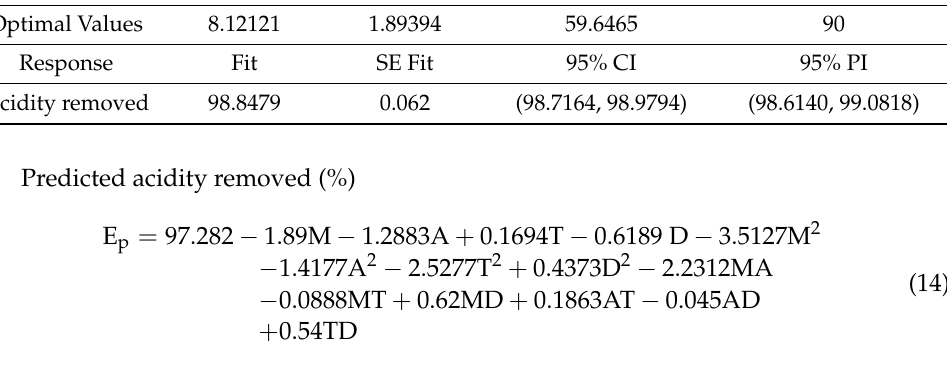
Figure 24. Acidity removed (experimental and predicted) as per the experimental run order.